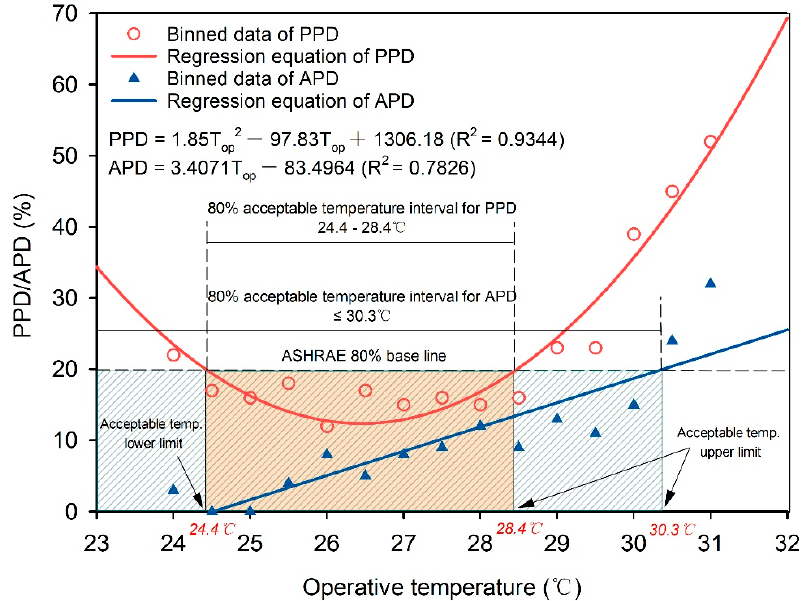
Figure 9. Acceptable temperature interval determined by APD and PPD.